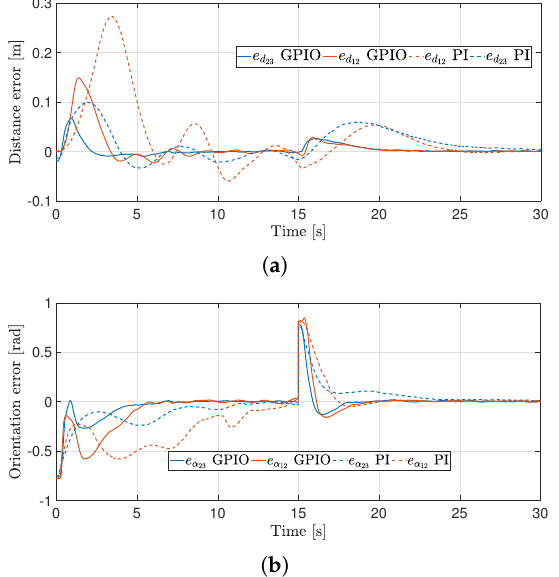
Figure 7. Distances and orientation angles errors for the first experiment. ( a ) Distance error. ( b ) Orientation